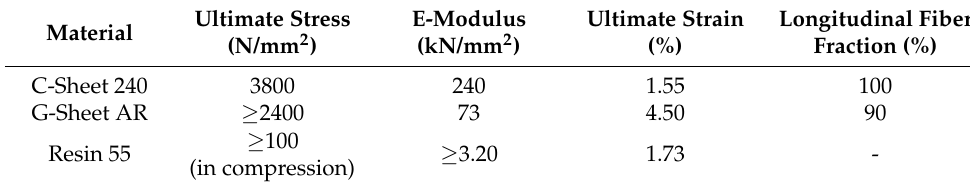
Table 3. Summary and designations of all test series.